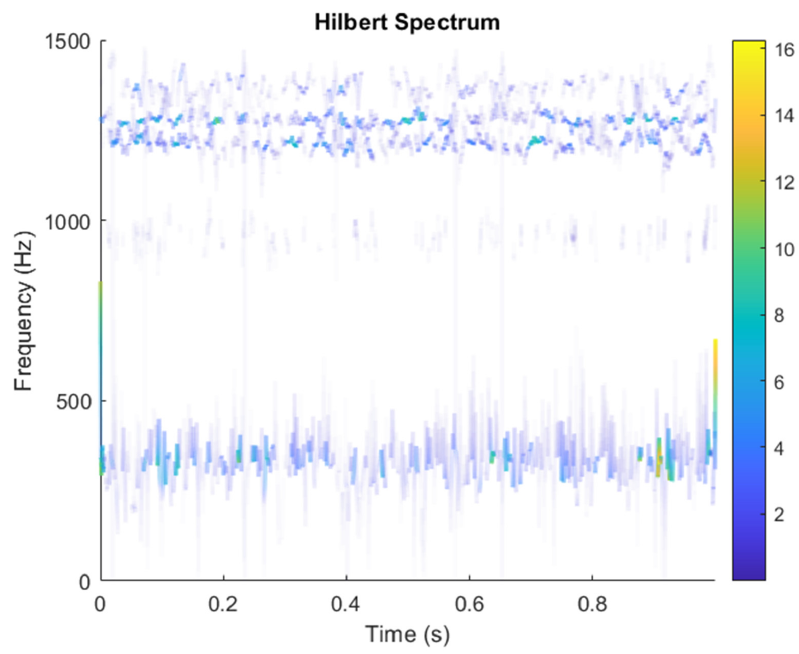
Figure 20. Analysis of data separated by VMD-ICA’s Hilbert Spectrum results.